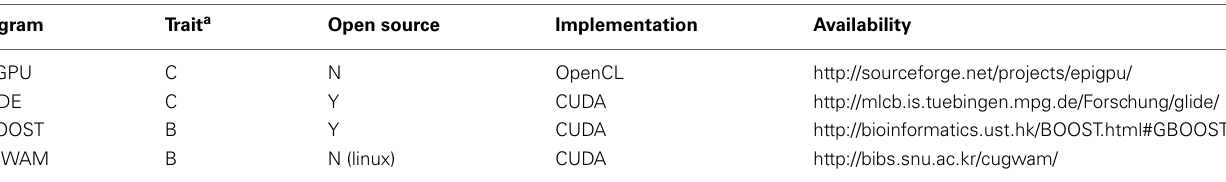
Table 2 | Summary of